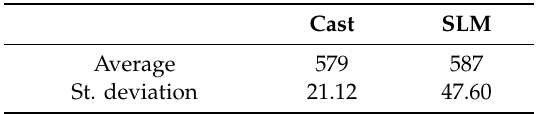
Figure 4. Optical microscope pictures obtained for tested sample: ( a ) cast sample; ( b ) SLM sample.